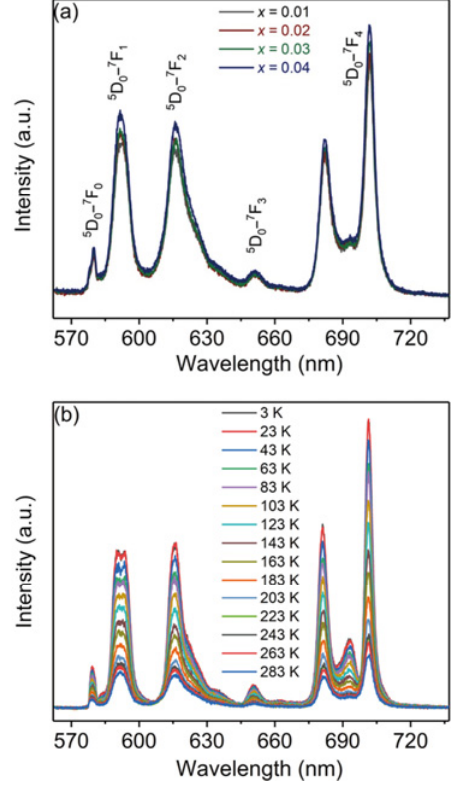
Fig. 10 (a) Emission spectra of LKNNS  EuNZ  x BZ samples excitated by a 375-nm solid laser; (b) temperature- dependent spectra of LKNNS  EuNZ 